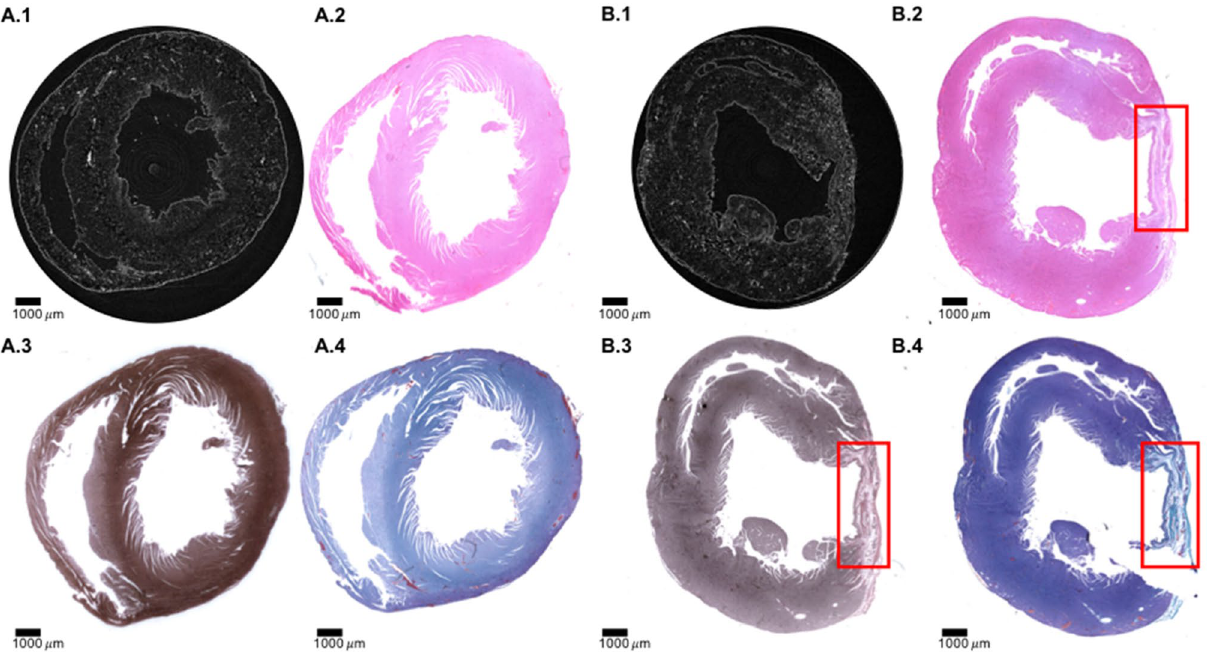
Figure 6. Comparison of PB X-PCI virtual histology and classical histology. One control heart from a healthy rat, and one infarcted heart from a rat with induced myocardial infarction was used. ( A.1–A.4 ) Control rat heart in short axis view. ( A.1 ) PB X-PCI virtual histology image. ( A.2 ) Hematoxylin–eosin, ( A.3 ) Gömöri’s silver staining, ( A.4 ) Mallory’s trichrome of the same heart. ( B.1–B.4 ) Myocardial infarction rat heart. ( B.1 ) PB X-PCI virtual histology image. ( B.2 ) Hematoxylin–eosin, ( B.3 ) Gömöri’s silver staining, ( B.4 ) Mallory’s trichrome of the same heart. Red boxes on ( B ) images indicate area of scar following myocardial